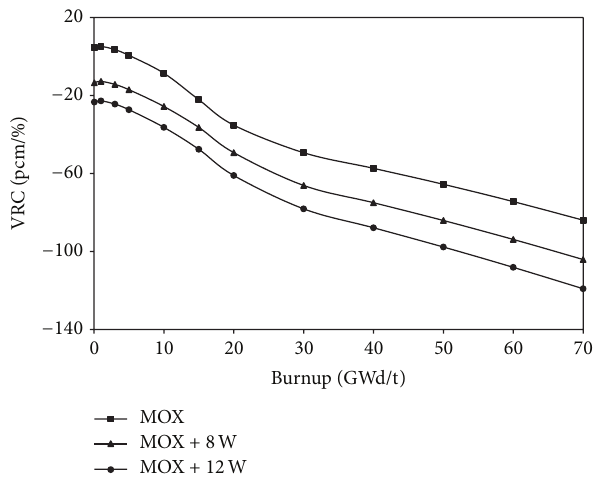
Figure 10: Void reactivity coefficients varying during burnup for modified assemblies’ designs.